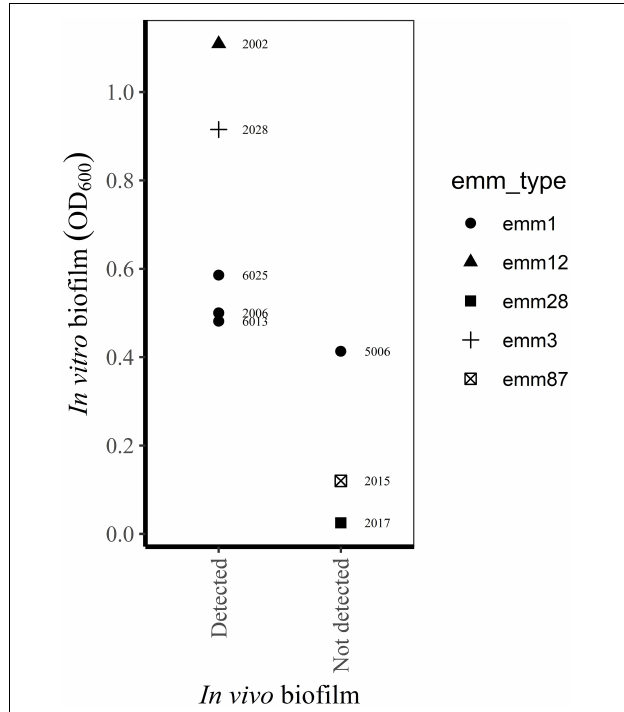
FIGURE 4 | Relationship between biofilm in vivo (Siemens et al., 2016) and in vitro biofilm forming capacity of bacterial isolates from the same biopsies (this